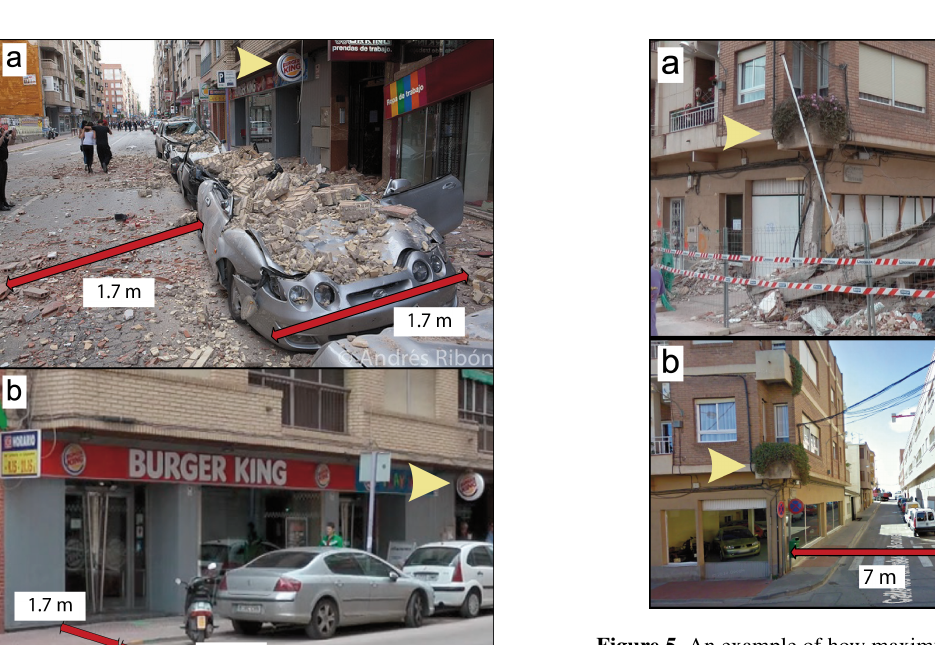
Figure 5. An example of how maximum impact distance was eval- uated. Photographs: (a) Marc Bertran Rojo and (b) Google